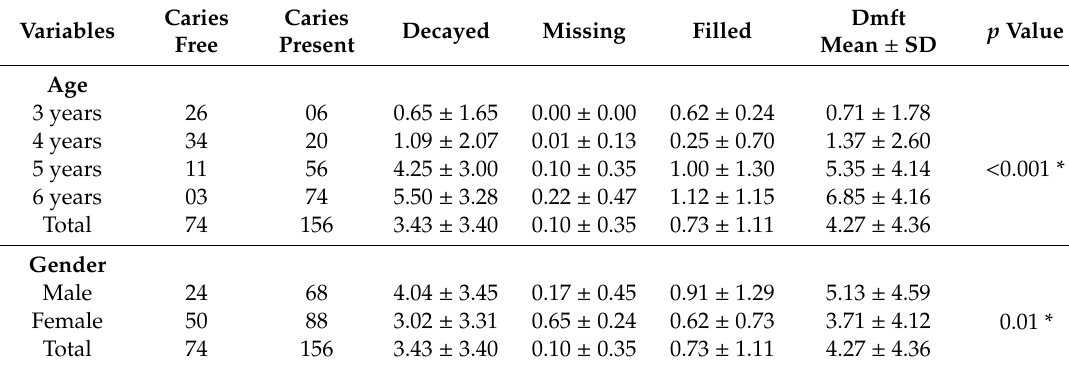
Table 3. Mean dmft score of preschool children, by age and gender.